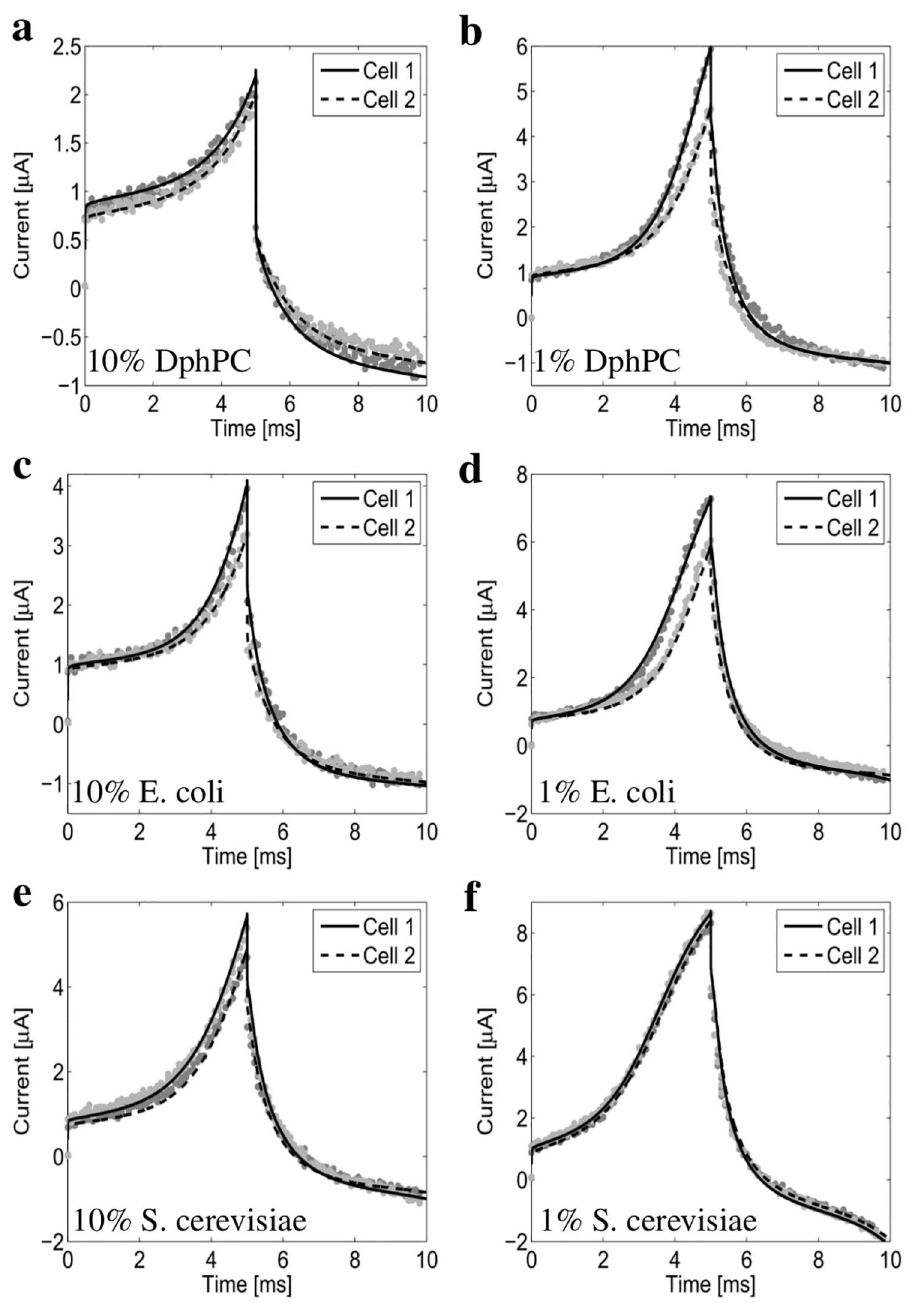
Fig 5. The measuredand numerically computed current response of the 1% and 10% tether density DphPC, S. cerevisiae, and E. coli membranes. The excitation potential V s is definedby a linear ramp of 100 V/s for 5 ms followedby a -100 V/s for 5 ms. Cell 1 and Cell 2 denote tethered membranes prepared using an identicalprocedure. All numericalresults are computed using the fractional order macroscopic model provided in the S1